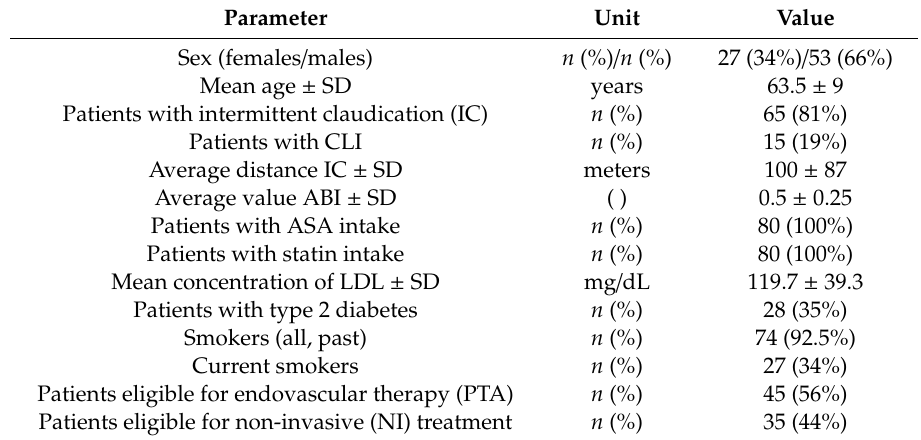
Table 1. General characteristics of the study group (PAD, n = 80 ). PAD: peripheral arterial disease.